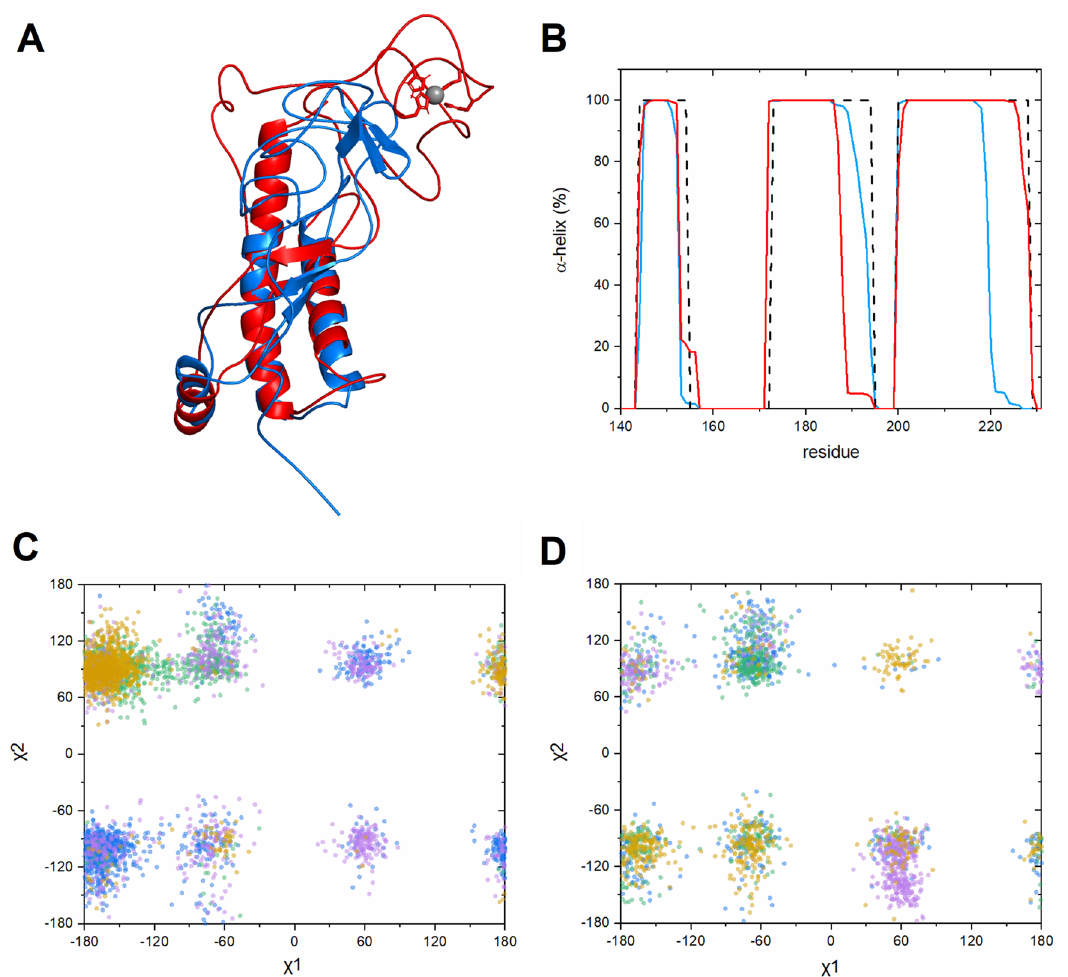
Figure 6. (A) Overlaid models of apo -PrP C (blue) and Zn(II)-bound PrP C (red), obtained at the end of the molecular dynamics simulations. The bound Zn(II) ion (gray) is coordinated by four histidine side chains from the PrP C octarepeat region. (B) The changes in α-helicity of the PrP C C-terminal domain during the whole time of the simulations for apo -PrPC (blue) and Zn(II)-bound PrP C (red), compared to the 1QLX 13 NMR model of PrP C (dashed black line). (C,D) Torsion angles χ 2 versus χ 1, characterizing the side chain conformations of tryptophan residues from the N-terminal domain of PrP C in apo form (C) and with a bound Zn(II) ion (D) . Trp65 is blue, Trp73 is green, Trp81 is violet, and Trp89 is